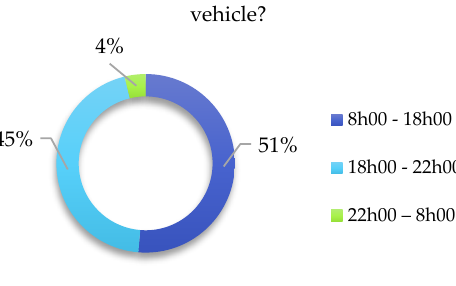
Figure 5. Supply Figure 5. Supply frequency-hours. Figure 5. Supply frequency-hours. Figure 5. Supply frequency-hours.